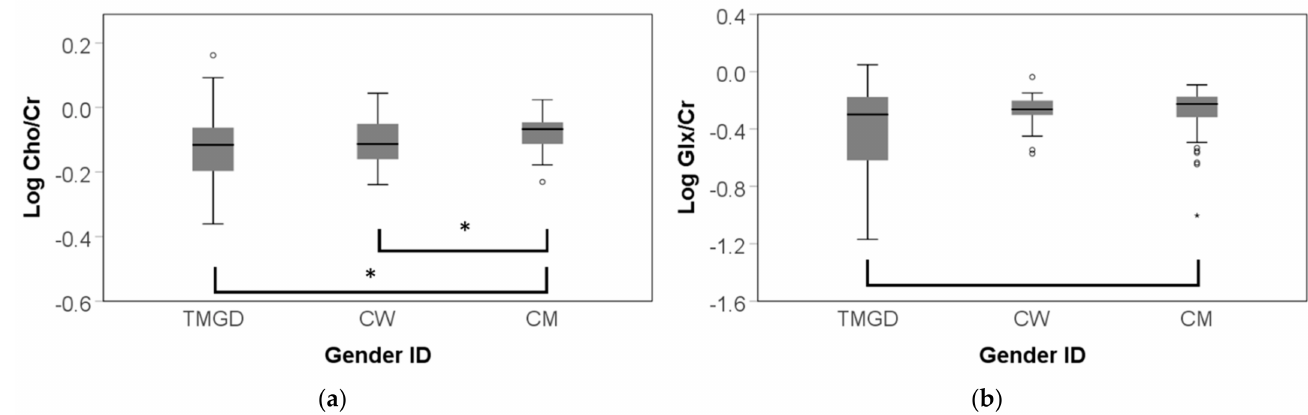
Figure 2. Group distributions of relative ratios in the amygdala-anterior hippocampus by gender identity (Gender ID). TMGD = trans men with GD; CW = cis women; CM = cis men; * p = <0.05; mild outliers are marked with a circle ( ◦ ), extreme outliers are marked with an asterisk (*) ( a ) Log Cho/Cr was significantly higher in CM compared to TMGD and CW; ( b ) Log Glx/Cr approached, but did not reach, a significant p